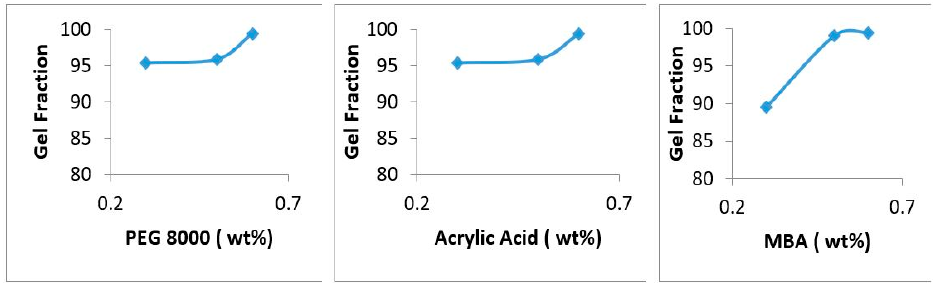
Figure 6. PEGAAM swelling dynamics at different pH levels.